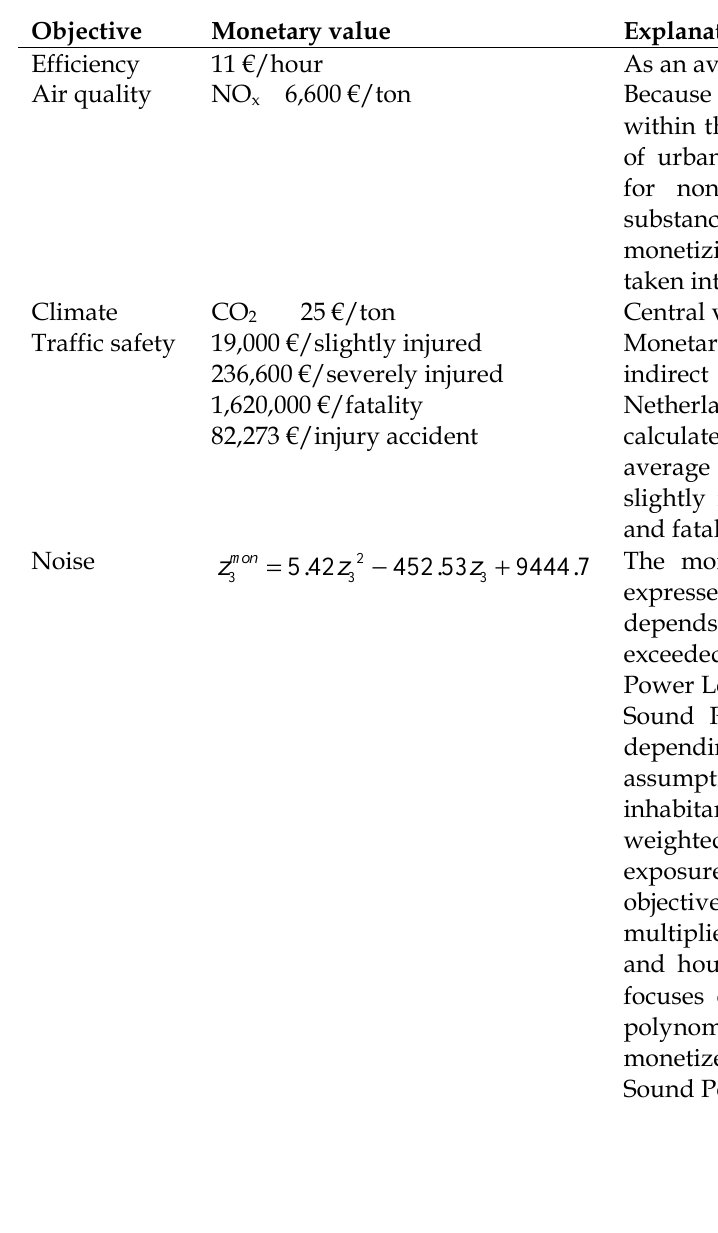
Table 3. Overview monetary values (Maibach et al.,